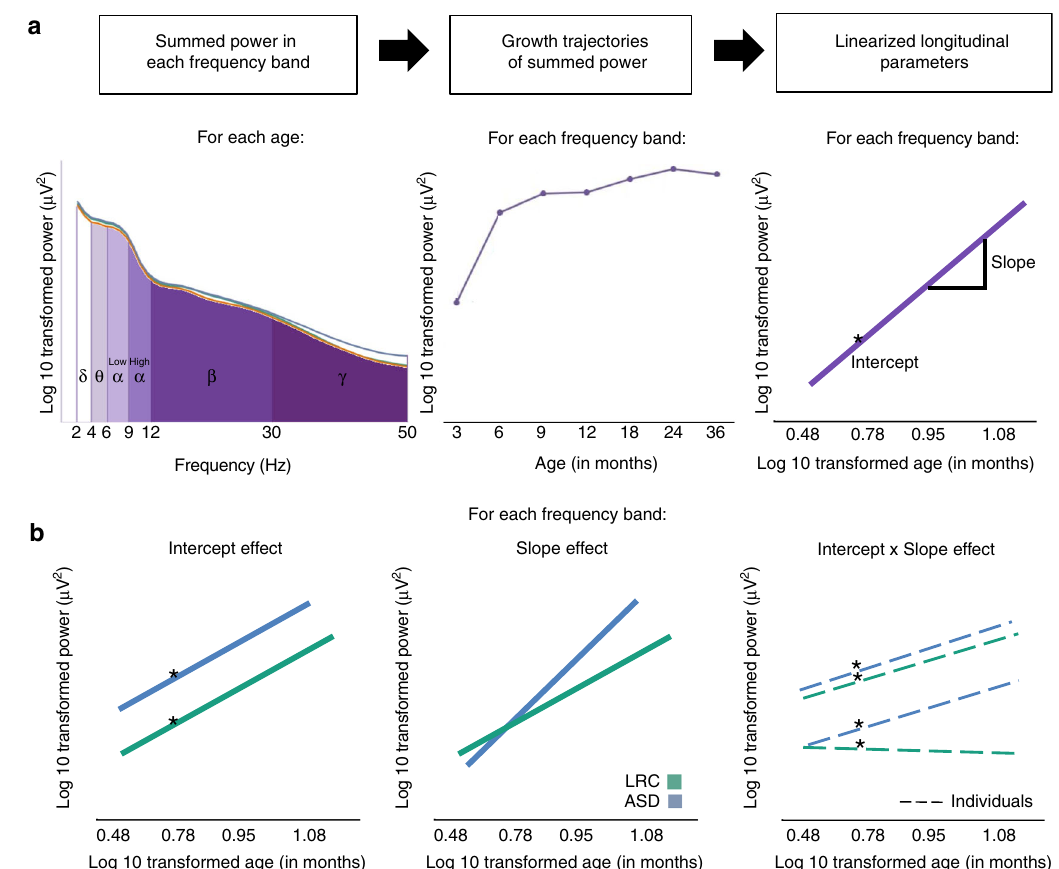
Fig. 2 Analysis schematic. Conceptual diagram illustrating how longitudinal EEG parameters were generated and analyzed. a (For each participant): at every age, the total, summed power in each canonical frequency band (delta, theta, low alpha, high alpha, beta, gamma labeled with their Greek symbol equivalents) was calculated as the area under the curve of the EEG power distribution (left panel). Growth trajectories of summed power in each frequency band were generated across (1) 3 – 12, (2) 12 – 24, and (3) 3 – 36 postnatal months of age (beta frequency band 3 – 36 month trajectories plotted here, middle panel). Growth trajectories of summed power from each frequency band were linearized by modeling log (summed power) as a function of log (age) for each frequency band; this allowed for the calculation of an estimated intercept (here, at 6 months) and a linear developmental slope for each individual with at least two EEG recordings to be submitted to group-level analysis (right panel, here for beta frequency band). b (Group-level effects): three types of effects were tested for in the data-driven model construction to differentiate all pairs of groups (here, the low-risk control (LRC, in green color) vs. Autism (ASD, in blue color) group comparison is shown): main effects of differences in intercepts (left panel), and developmental slopes (middle panel), and interaction effects between intercept and slope (right panel). The interaction effect tested whether the relation between intercept and slope varied between groups (e.g., here, individuals in the ASD group have the same slope regardless of having low or high intercept values, but individuals in the LRC group have steeper slope values with higher intercept